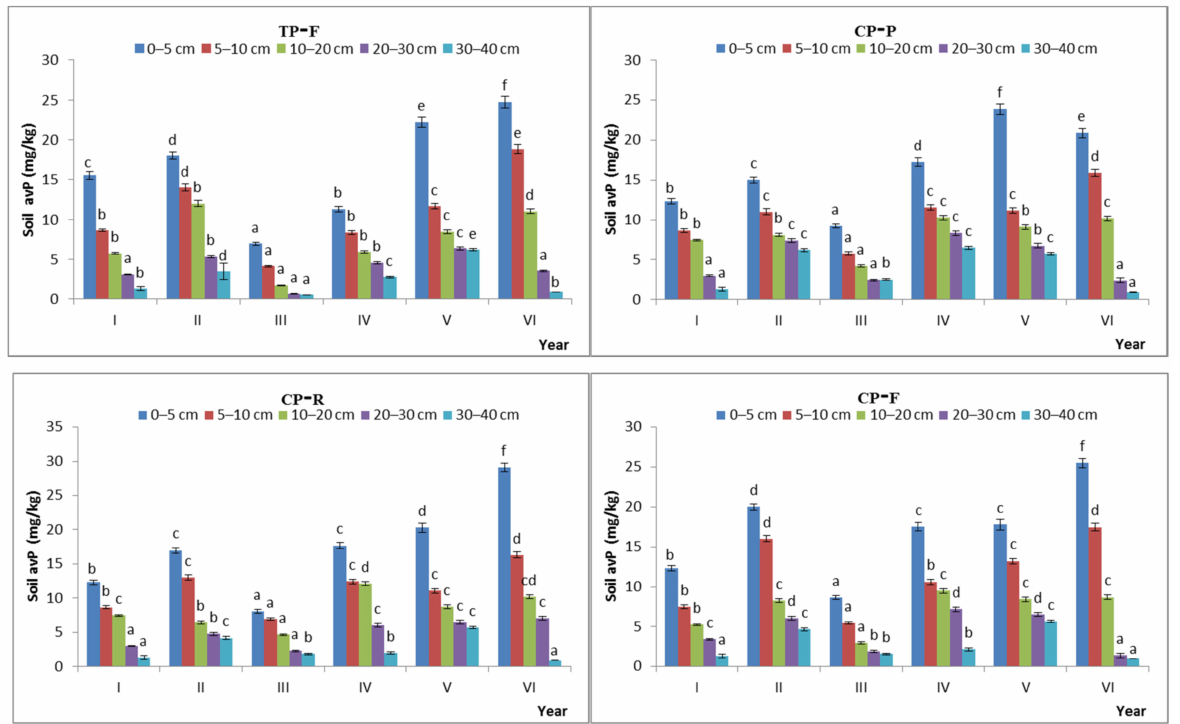
Figure 9. Characteristics of available phosphorus content during the natural recovery process in different steady-state alpine Kobresia meadows. Note: P: grazing-prohibited plot; R: reduced- grazing plot; F: free-grazing plot; GK, KH, TP, and CP: Gramineae- K. humilis meadow, K. humilis meadow, K. pygmaea meadow with mattic epipedon thickening, and K. pygmaea meadow with mattic epipedon cracking, respectively; I, II, III, VI, V, and VI, indicate 2013, 2014, 2015, 2016, 2017, and 2018, respectively; “a”, “b”, “c” and “d” are the coefficients of significance for different